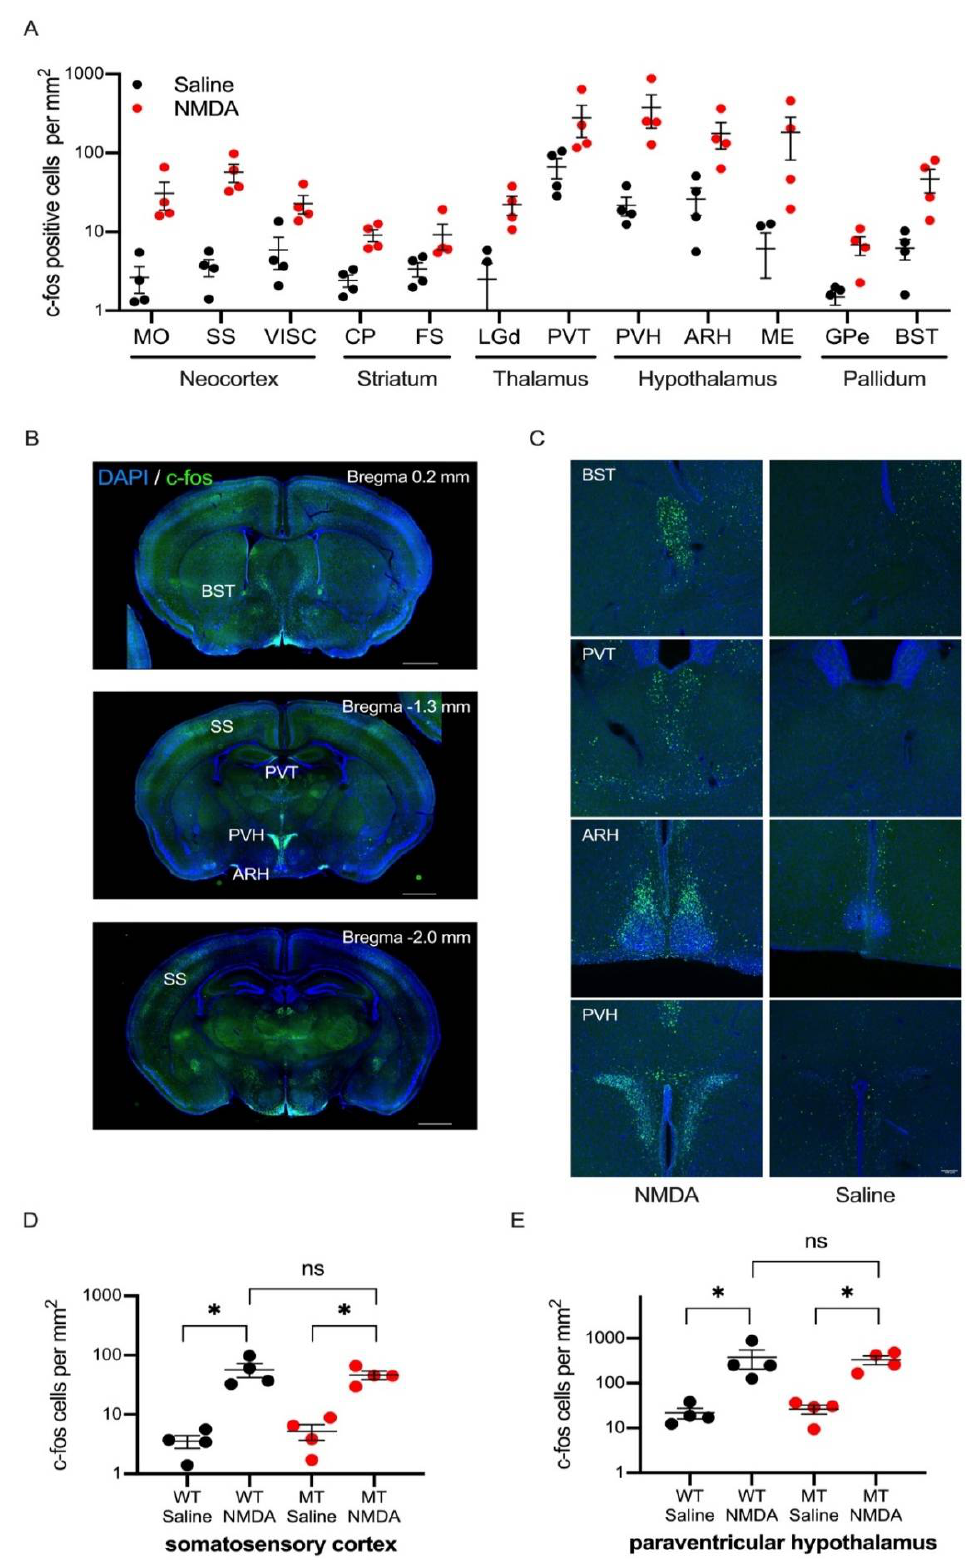
Figure 2. c-fos expression after NMDA-induced seizure in wild-type mice. ( A ) Density of c-fos positive neurons across different brain regions in saline- (black) or NMDA- (red) injected mice are depicted in the graph. Brain regions which exhibited a significant increase in the c-fos positive neurons are shown in the graph. Full data is available in Supplementary Table S1. Abbreviations (MO: so- matomotor areas, SS: somatosensory areas, VISC: visceral area, CP: caudoputamen, FS: fundus of striatum, LGd: dorsal part of lateral geniculate complex, PVT: paraventricular nucleus of thalamus,